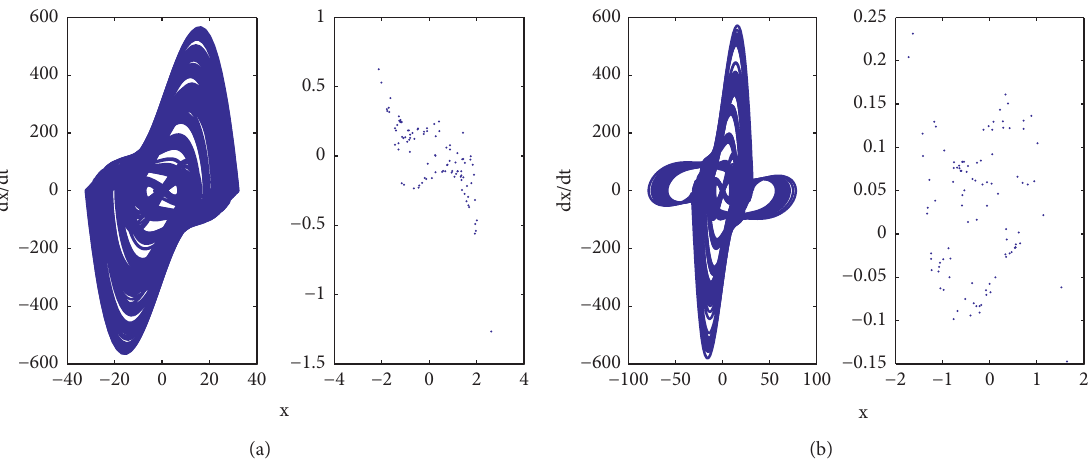
Figure 10: Phase portraits and its corresponding Poincar´e maps illustrating the chaotic behavior of the new chemical system (1) with the parameters of Figure 9 for (a) f � 3 , p � 1 . 0 and (b) f � 1 . 8 ,p � 1 . 1.